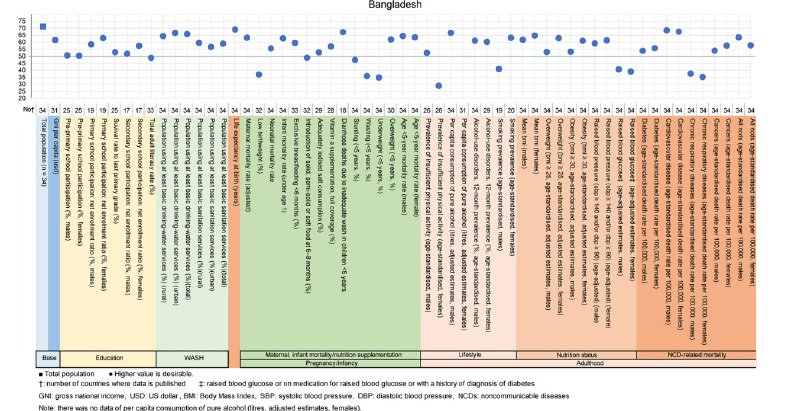
Fig 6. Country diagnosis by the deviation graph for